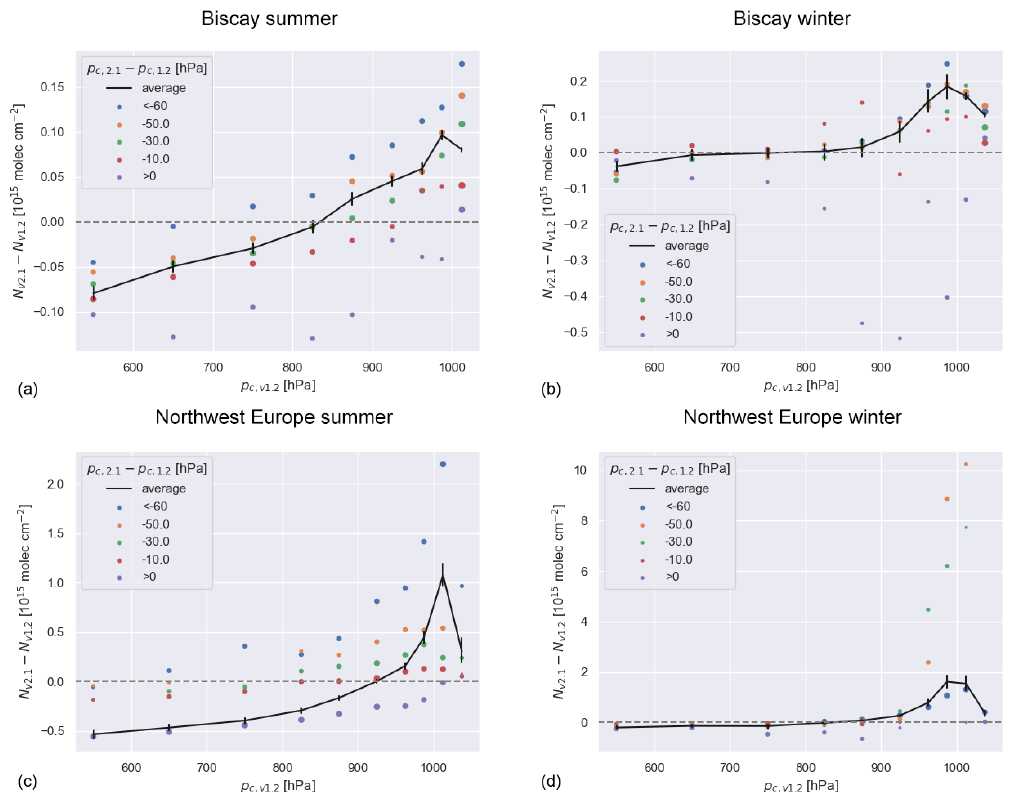
Figure 7. Difference between tropospheric NO 2 columns retrieved with TROPOMI v1.2 and v2.1 as a function of the v1.2 cloud pressure for 27 June–6 July 2018 over the mildly polluted Bay of Biscay in summer (a) and winter (b) , as well as the highly polluted Northwest Europe (c, d) . Colors indicate the difference in cloud pressures between the two versions. The marker size is proportional to the logarithm of the sample size, and the black line shows the effective